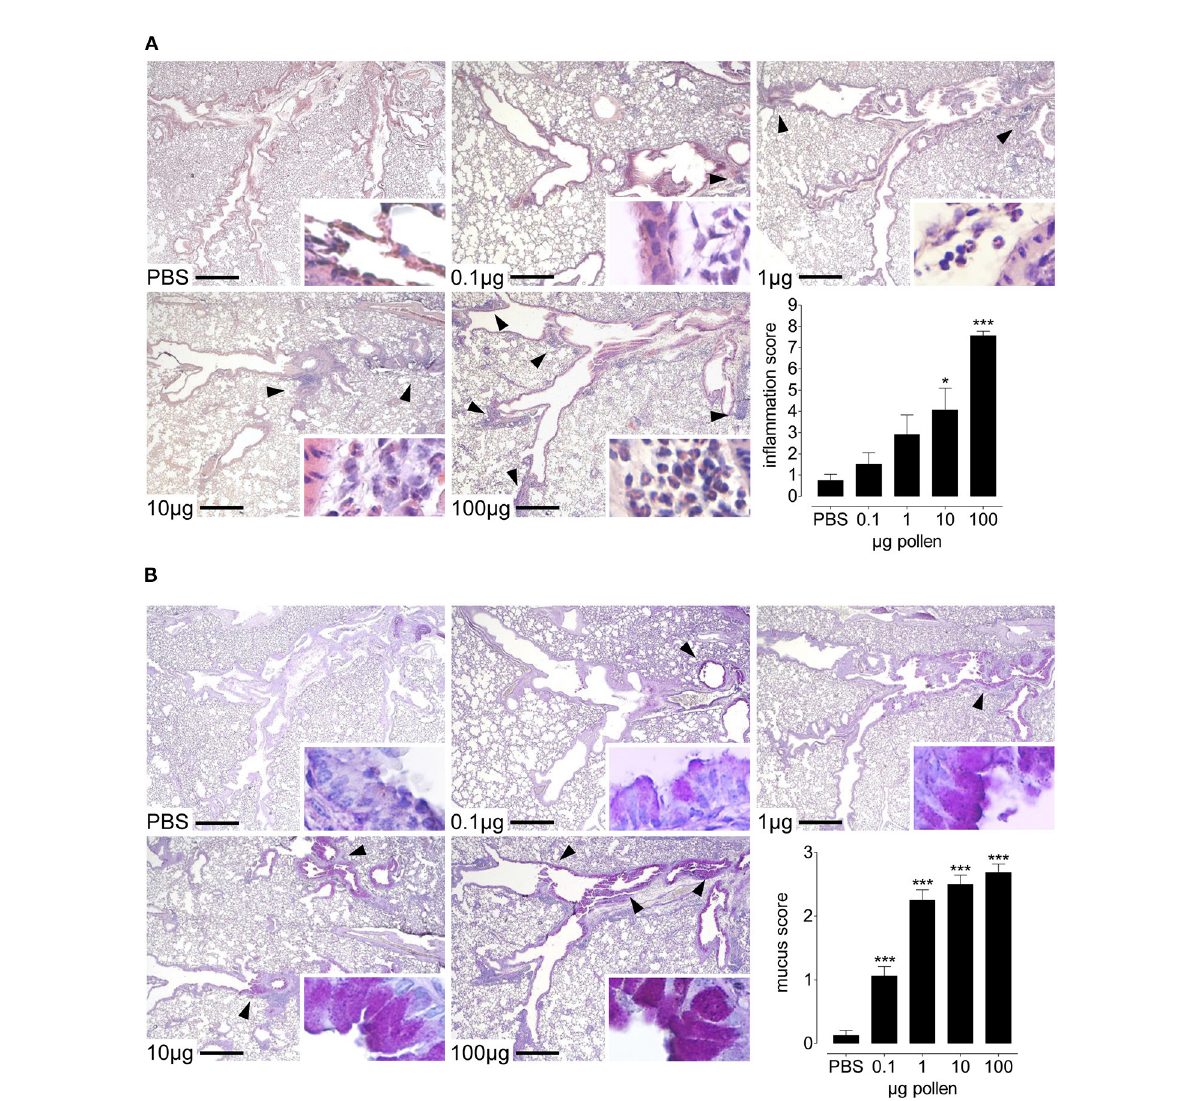
FIGURE3 Dose-dependent lung inflammation and mucus production in response to increasing doses of AG1 RWP. Representative photomicrographs of H & E- and PAS- stained lung tissue sections from PBS alone, 0.1, 1, 10, and 100 µ g per 50 µ l PBS AG1 RWP doses without added adjuvant over 21 days at a magnification of 40 × . (A) In H & E-sections, PBS-treated mice had normal tissue without evidence of inflammation, whereas RWP administration induced inflammatory infiltrates containing eosinophils (insets 400 × ). Arrows indicate inflammatory infiltrates. (B) In PAS-stained lung tissue sections, naïve mice had no mucus in the goblet cells but RWP immunized mice had mucus in the goblet producing cells (arrows). Scale bars are 500 µ m. Graphs illustrate the quantification of the lung sections using a blinded semi-quantitative scoring system. Data are presented as mean ± SEM and are representative of at least two experiments; n = 8 . Asterisks indicate significant differences vs PBS, * p < 0.05 , *** p < 0.001 , chi-square test.